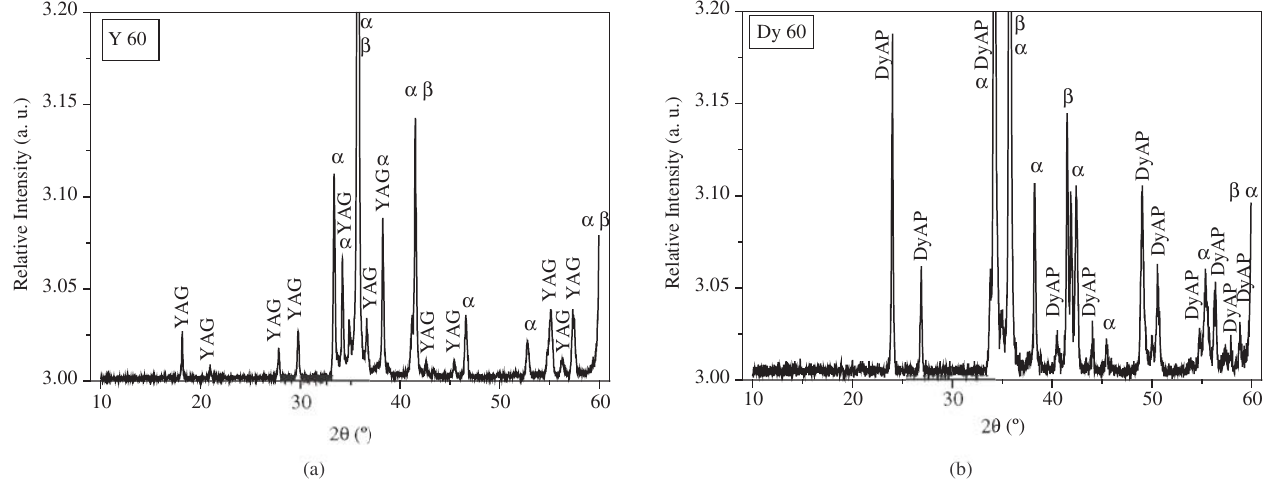
Figure 3. X-ray diffratograms patterns of RE 60 samples sintered at 1800 °C/1h: a) RE = Y; b) RE = Dy.